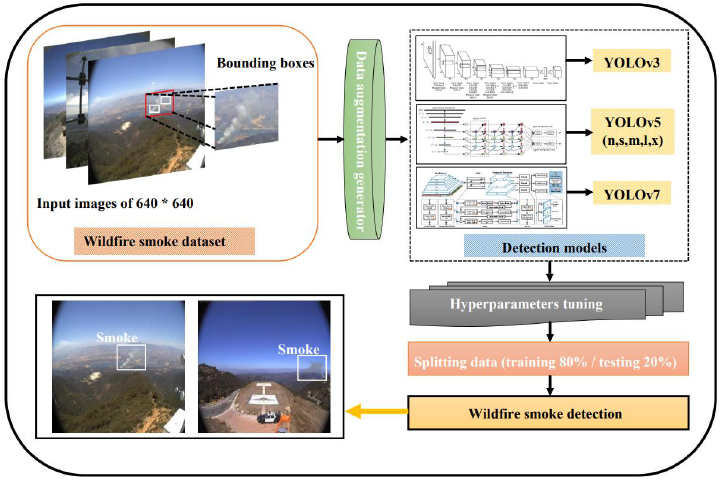
Figure 2. Flowchart of the Proposed Wildfire Smoke-Detection Methodology.